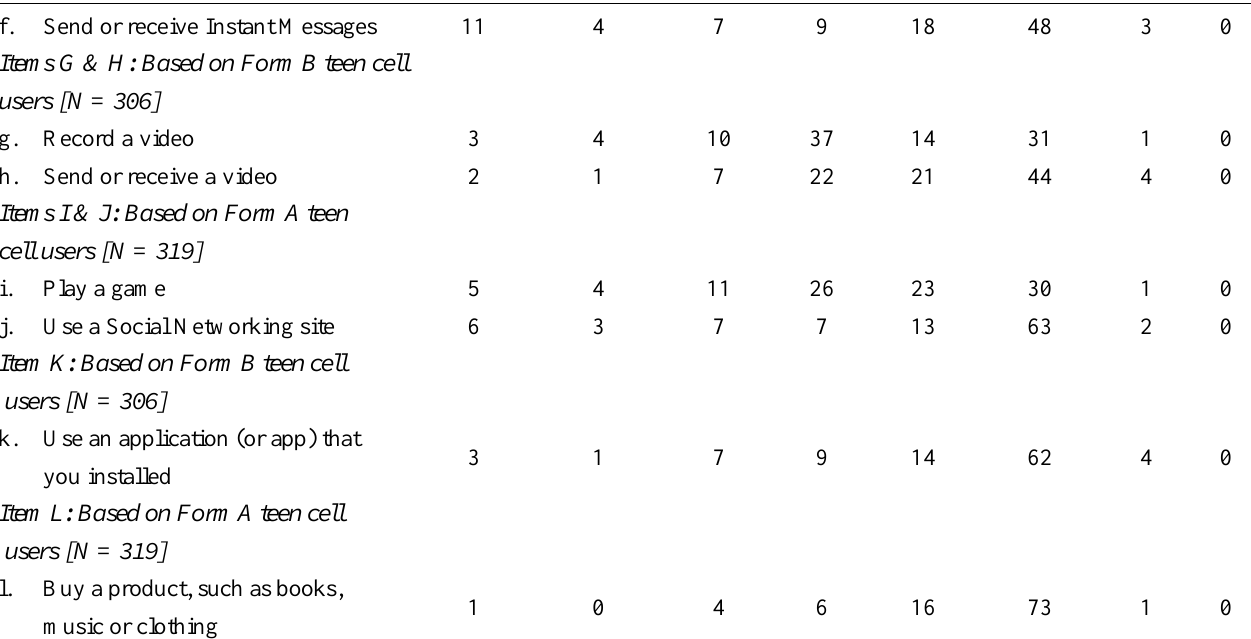
Table A3. On an average day, about how many text messages do you send and receive on your cell phone? OR Well, on an average day, would you say you send